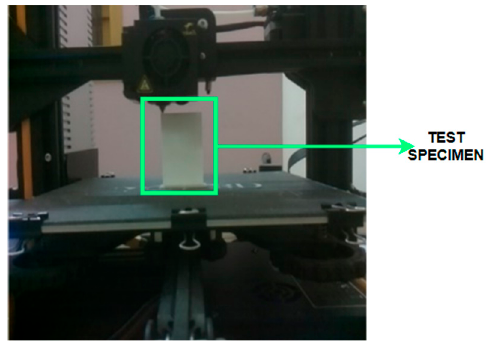
Figure 9. Test specimen .